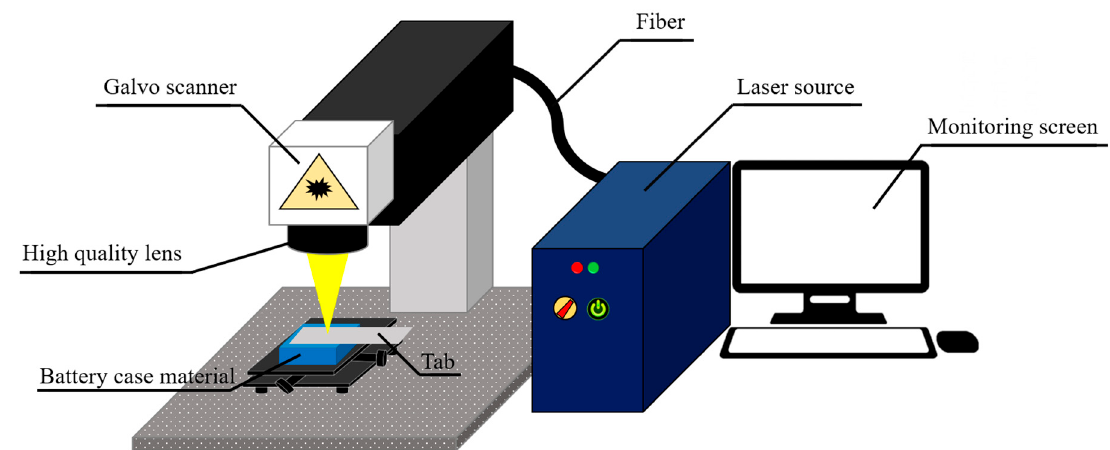
Figure 1. Experimental schematic of the battery case sample and tab welding.